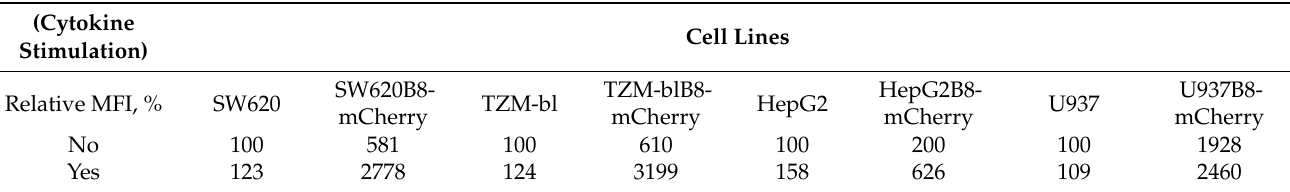
Table 1. Relative median fluorescent intensity of 10.000 control and modified cells following 72 h incubation with 1000 U/mL of IFN- γ and 500 U/mL of TNF- α . Three independent repeats were performed for each cell line. The standard deviation is below 10% in each case. The MFI of control untreated cells is